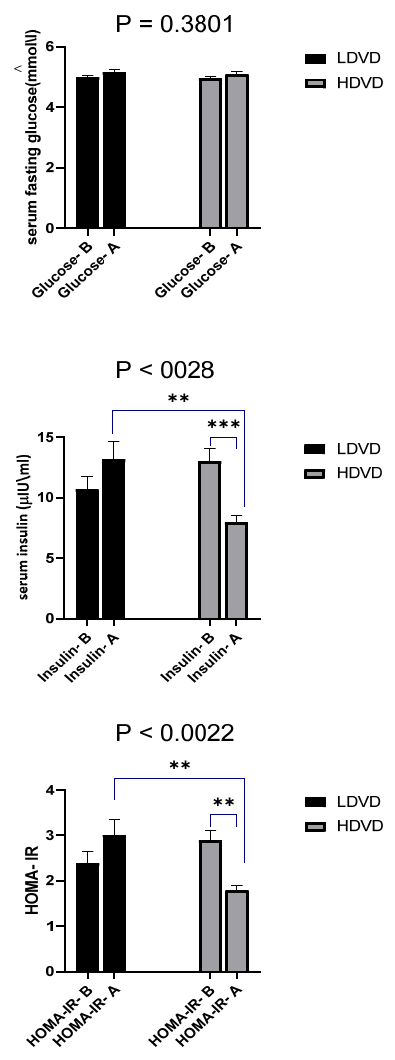
Figure 3. Comparison of measurements of glucose, insulin and HOMA-IR. Comparison was carried out between LDVD and HDVD groups and their levels before (B) and after (A) treatment of the same group using two-way analysis of variance followed by Tukey’s multiple comparison test. Bars represent the serum concentration of the biochemical variable. Error bars represent standard error of the mean (SEM). Exact p -values are recorded on graphs. Data were considered significant if p < 0.05. ** p < 0.01, *** p <